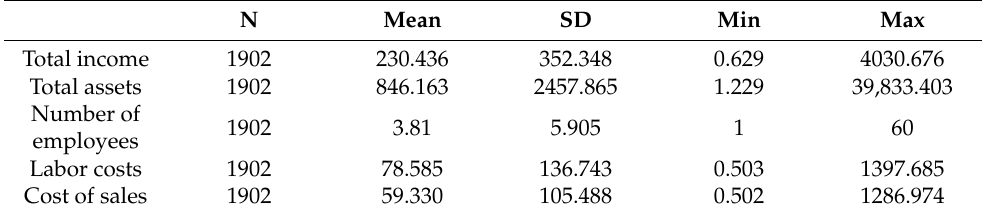
Table 2. Rural tourism: descriptive statistics.